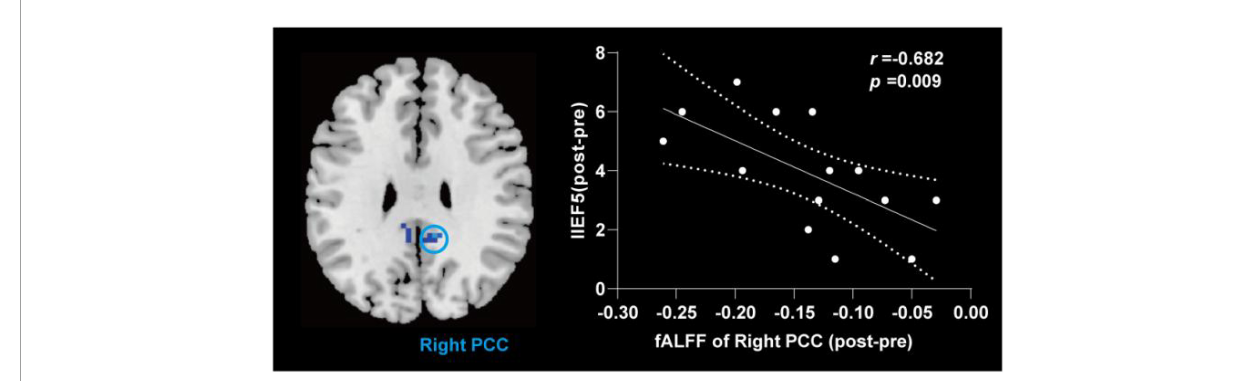
FIGURE5 Correlation analysis between change value of fALFF and change of the IIEF5 score after electroacupuncture treatment in patients with PED. fALFF, fractional amplitude of low frequency fluctuation; IIEF5, 5-item international index of erectile function; PCC, posterior cingulate cortex; PED, psychogenic erectile dysfunction; NC, normal control; EA, after electroacupuncture